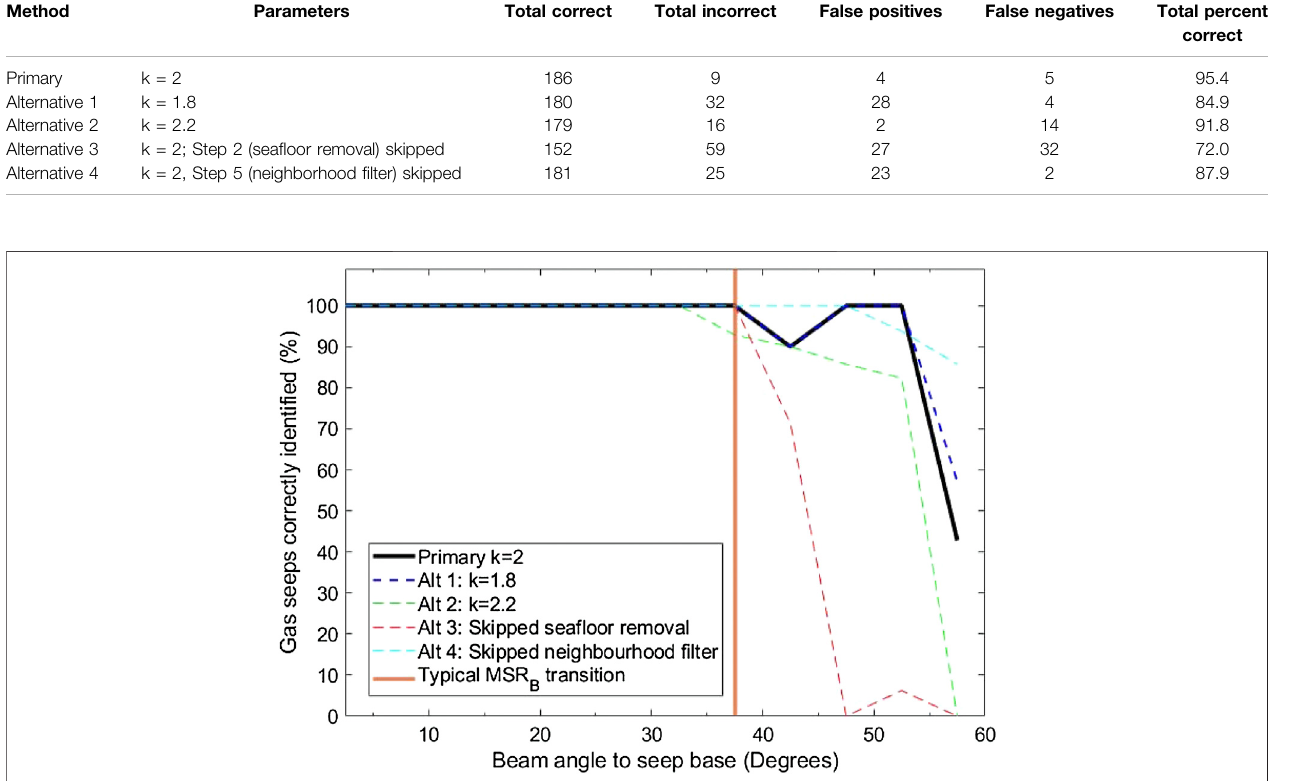
FIGURE 9 | Percentage of seeps correctly identi fi ed by beam angle to seep base. The solid black line shows the results of using the primary method (k = 2), and dashed lines show the results using the alternative methods. Different parameters for each method are indicated by the colour. Percentages were calculated using only the count of correct seeps identi fi ed divided by the total number of lines containing a seep. The vertical orange line represents the typical transition between the MSR A and MSR B data. Seeps detected at beam angles greater than 37.5 ° would generally be within the sidelobe interference of the MSR B data.